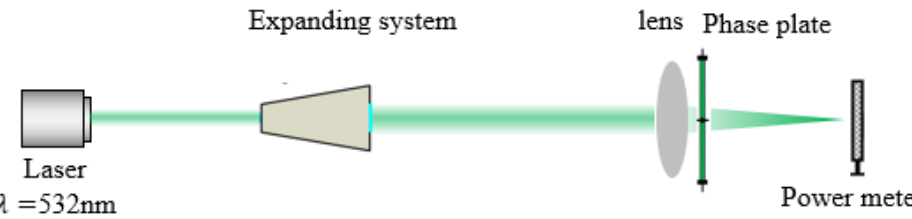
Figure 8. Sketch map of the experimental setup to measure the transmittance of phase plate.